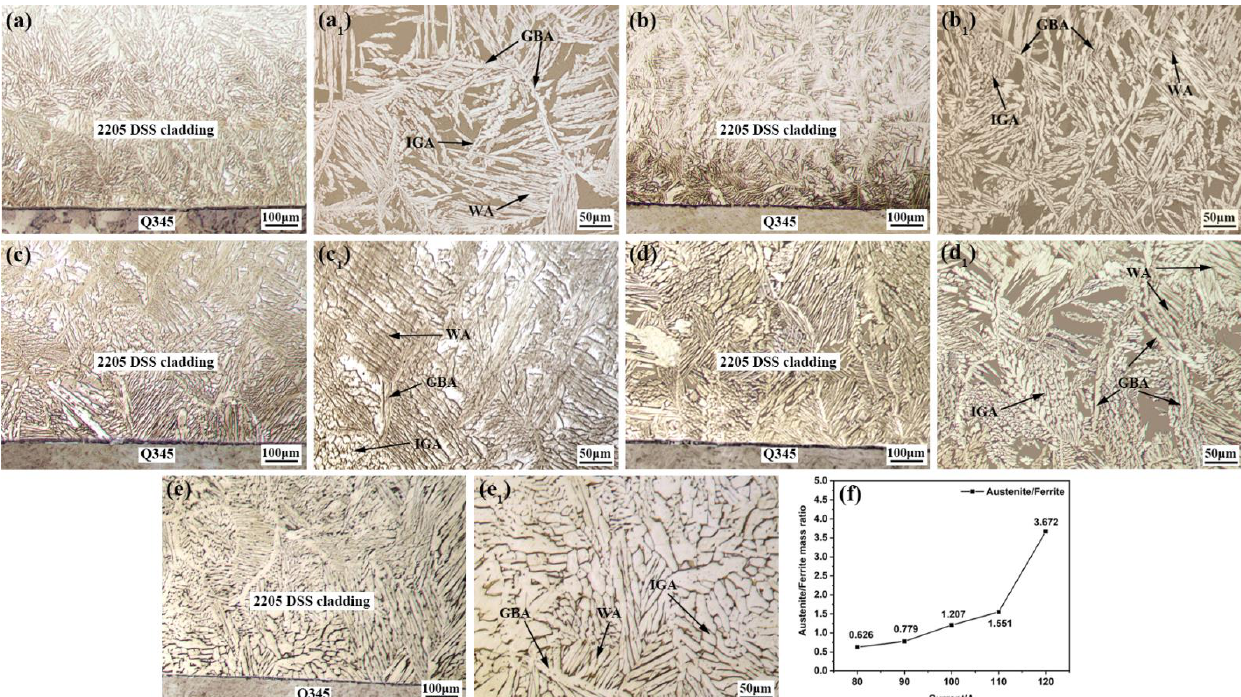
Figure 5. Microstructure of specimens under different current and Austenite/ Ferrite mass ratio. ( a , a 1 ) 80 A; ( b , b 1 ) 90 A; ( c , c 1 ) 100 A; ( d , d 1 ) 110 A; ( e , e 1 ) 120 A; ( f ) Austenite/ Ferrite mass ratio in mirostructure.